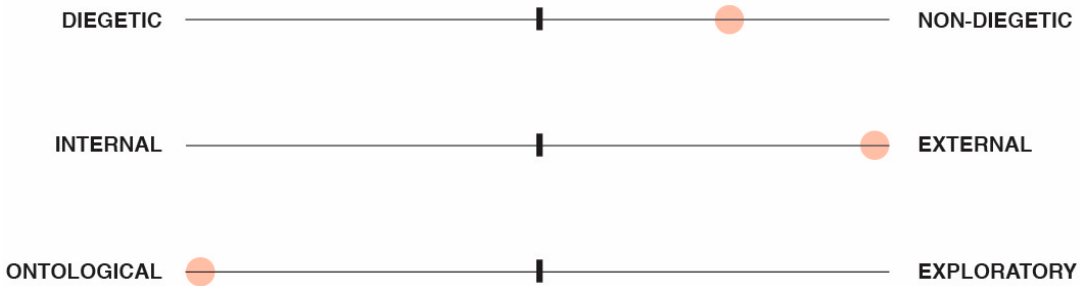
Figure 7. Mapping the pilot project Mapping Place using the TENF .